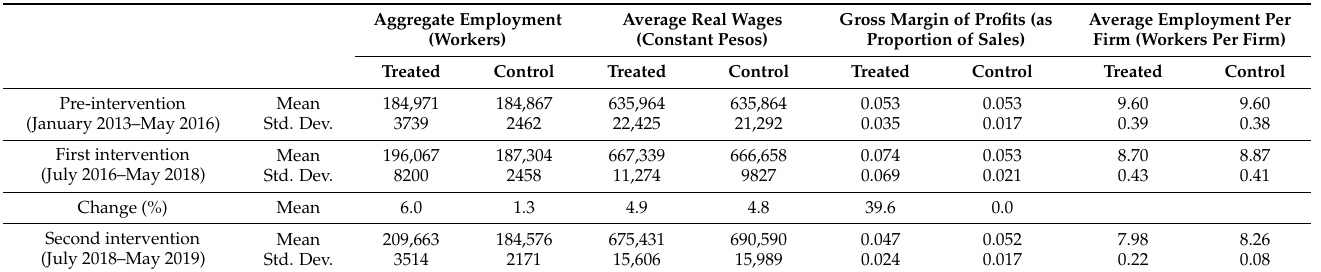
Table 1. Descriptive statistics for aggregate employment (number of workers), average real wages (in constant Chilean pesos), average number of workers (number of workers per firm), and gross profit margins (as proportion of sales). Average Real Wages (Constant